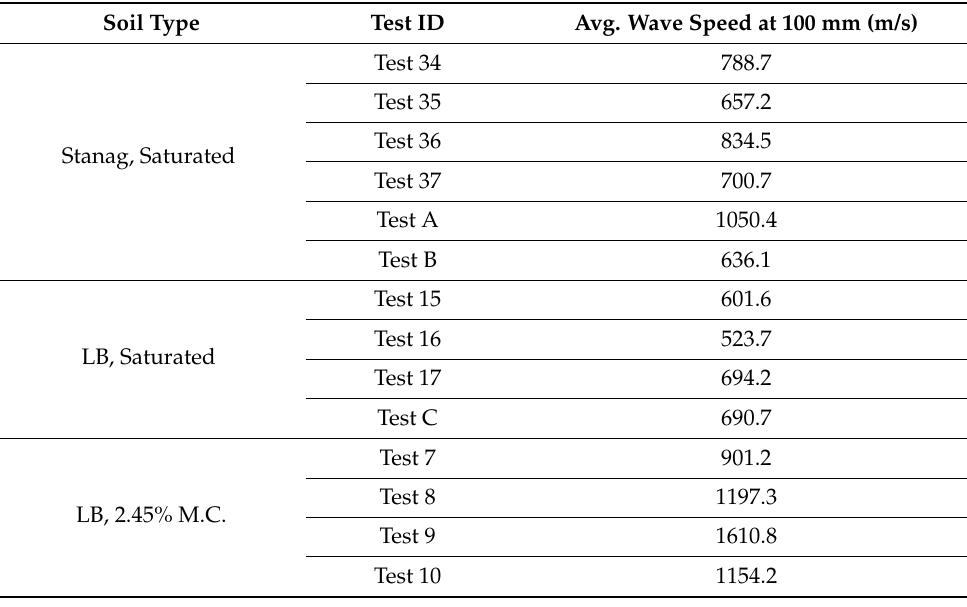
Table 2. Wave speeds calculated from CoBL TOA